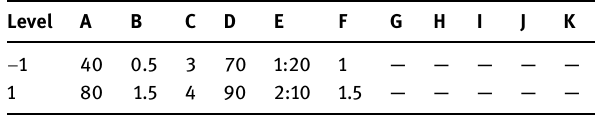
Table 1: Parameters in the Plackett – Burman experimental